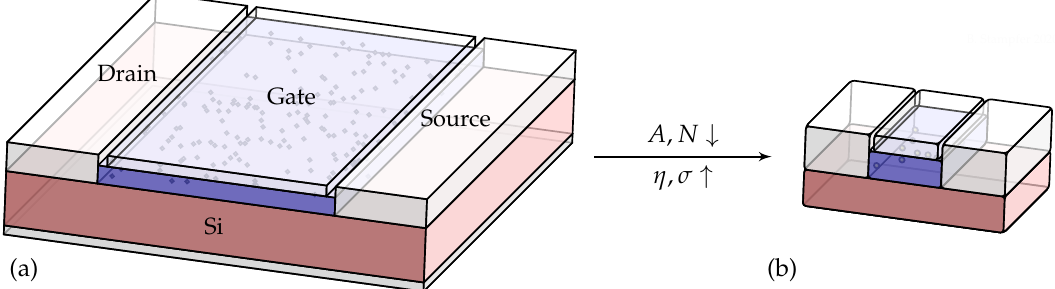
Figure 1. Illustration of oxide defects in ( a ) large- and ( b ) small area devices. As the gate area A is reduced, fewer defects N will be present in the device, but on average each defect will have a larger impact η on the overall degradation. This increases variability σ among nominally identical devices, but also allows characterization of single defects using methods such as random telegraph noise (RTN) analysis and time-dependent defect spectroscopy